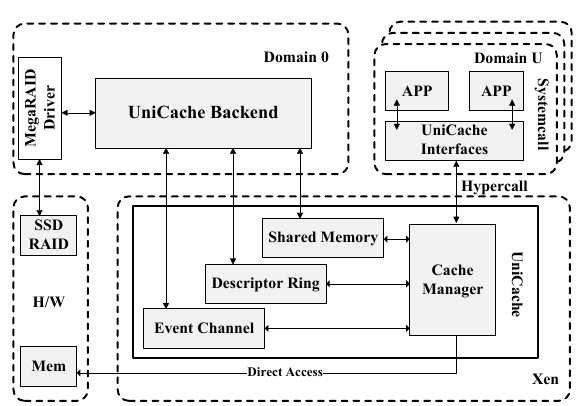
Fig. 1. The structure of UniCache store with hypervisor and SSD